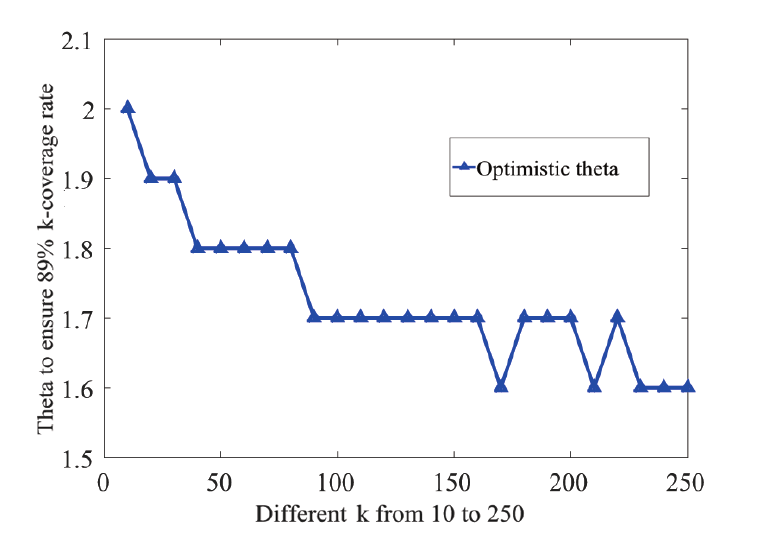
Figure 8. Different k and the corresponding optimal θ